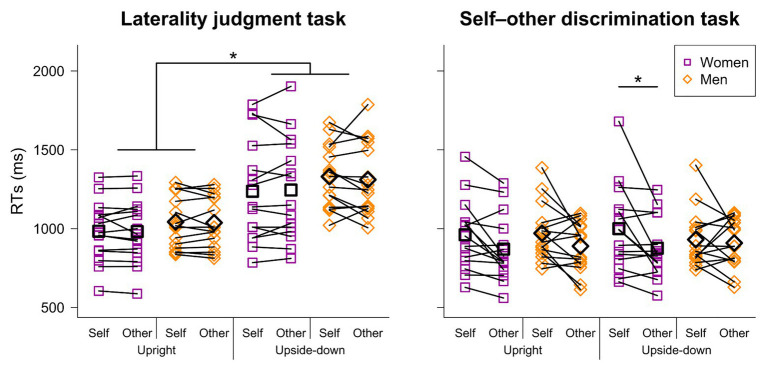
Reaction times (RTs) in the laterality judgment and self-other discrimination tasks. While no significant difference between the self and other conditions was noted in the laterality judgment task, RTs for the other hand image were significantly shorter than those for the self-hand image when the upside-down image was presented in the self-other discrimination task (see the text for detailed results). A black-lined square and diamond in each condition indicate mean values for women and men, respectively.